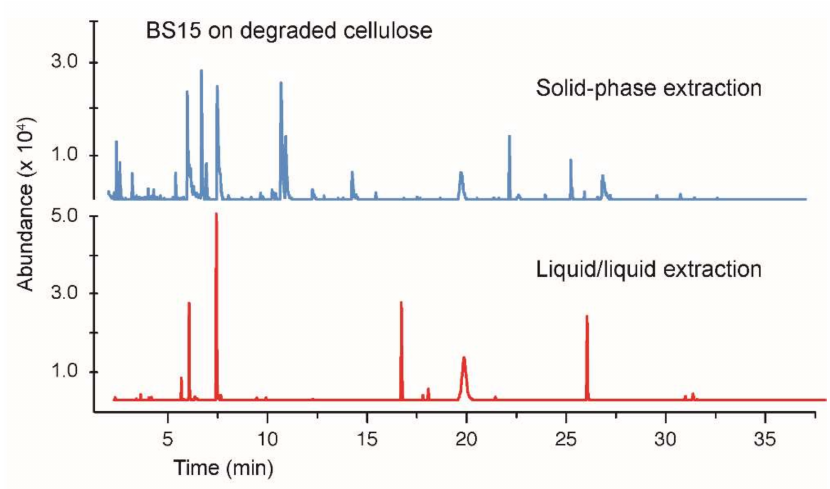
Figure 7. A comparison of the solid-phase extraction versus the liquid–liquid extraction (ethyl acetate/water). The growth media contained BS15 grown on the degraded cellulose as a carbon